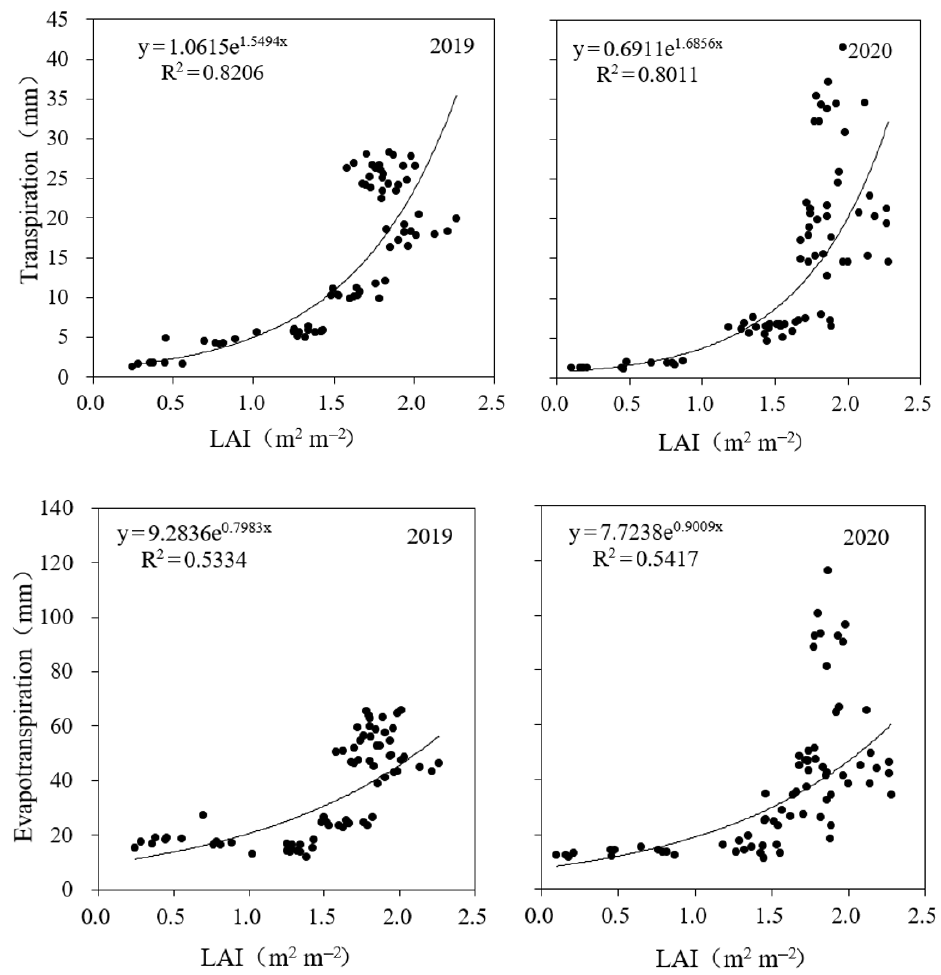
Figure 5. Relationship between LAI and transpiration (T) or evapotranspiration (ET) in 2019 and 2020.